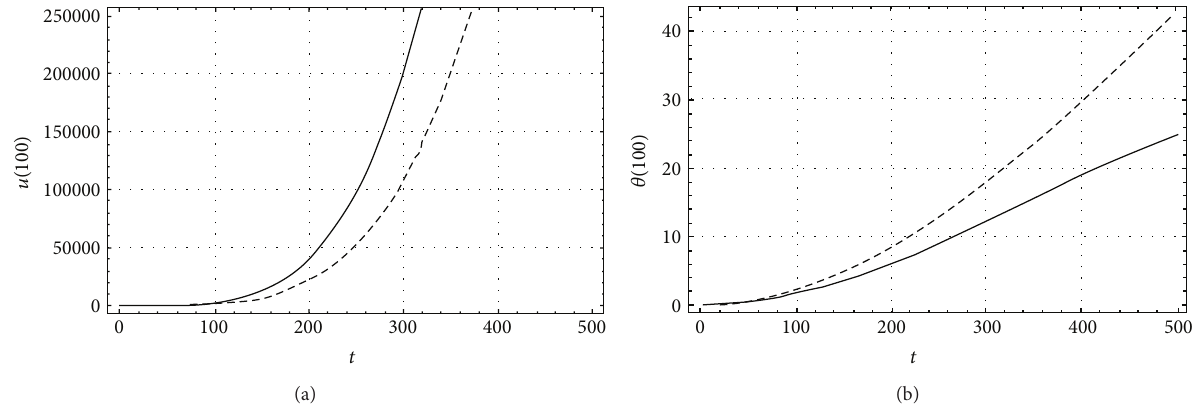
Figure 13: The displacement as a function of time and the temperature without and with rotation and magnetic field (GL) at 𝑥 = 100 , 𝑎 = 0.5 , = 0.5 , 𝐴 = 0.001 , 𝑏 = 0.5 , 𝛼 = 1 , 𝛽 𝛽 1 = 0.1 , - - -). 𝜎 2